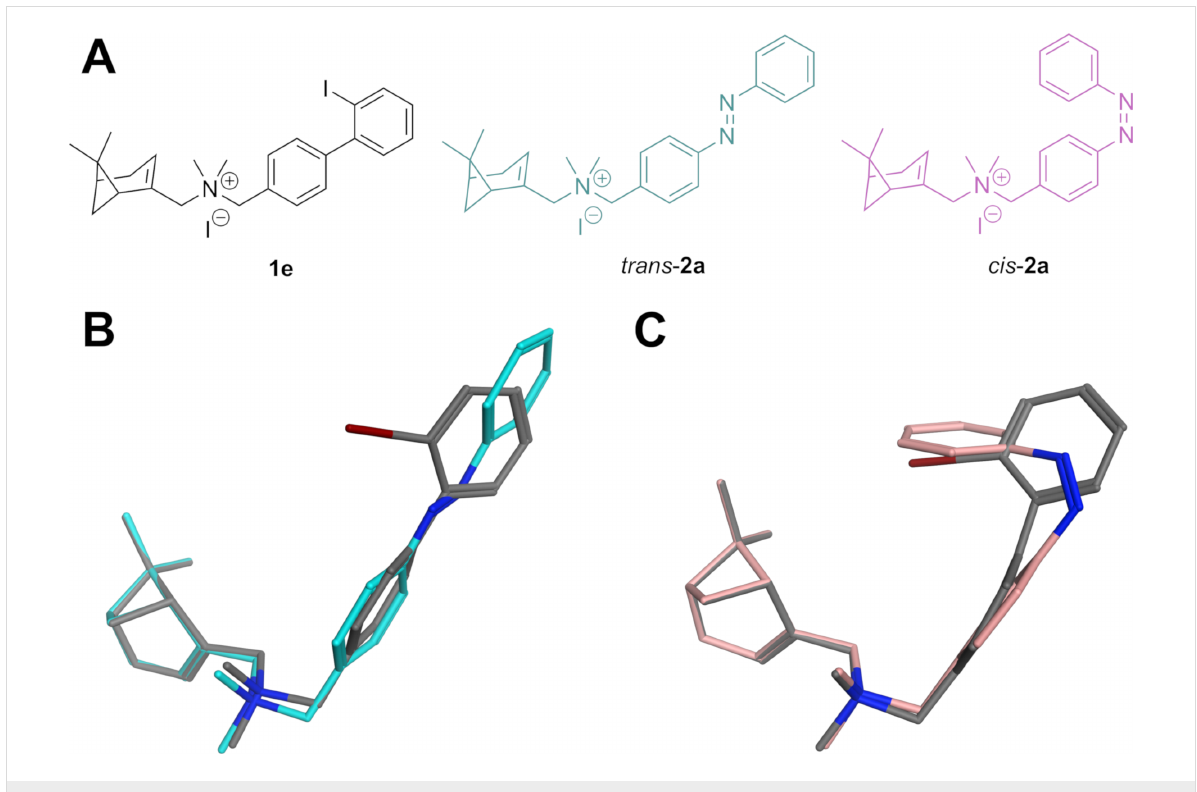
Figure 2: Conformational alignment of a biaryl CXCR3 agonist with a designed azobenzene analogue. A) 2D structure of biaryl CXCR3 agonist 1e and designed ligand trans - 2a and cis - 2a . B,C) Alignments of 1e (grey carbon atoms) and 2a , in which the trans and cis -isomers are shown in (B) turquoise and (C) light magenta carbon atoms, respectively. The iodine atom is shown in red for